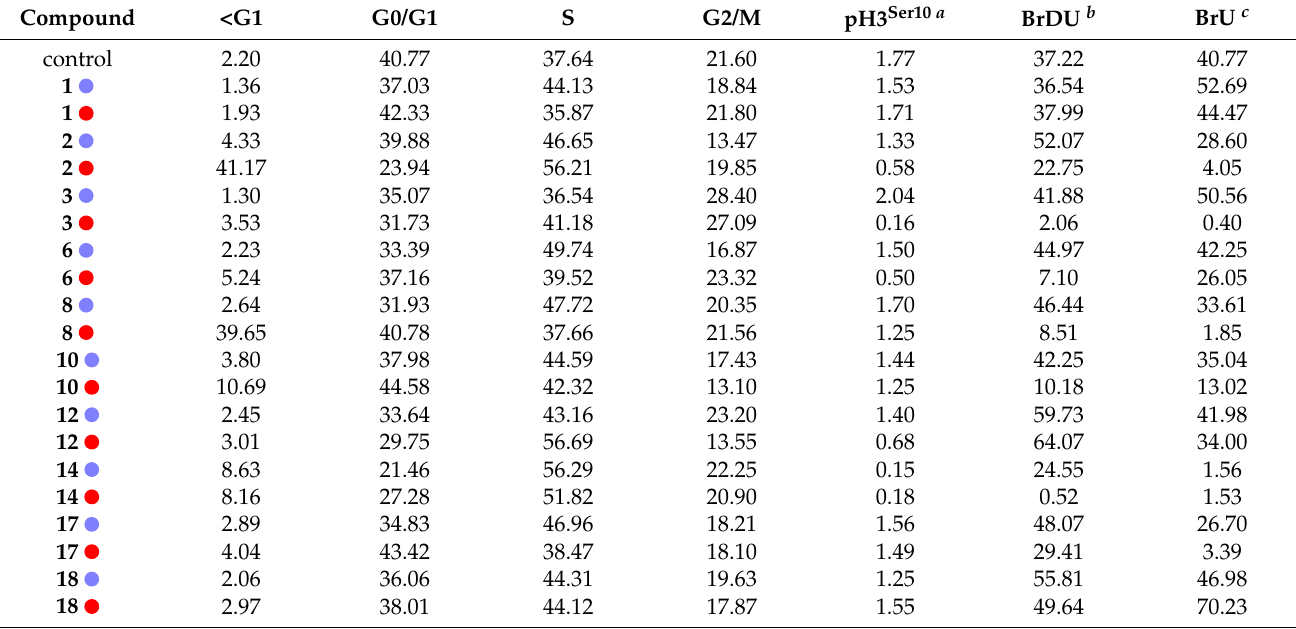
Table 1. Summary of cytotoxic activities (IC 50 , μ M).